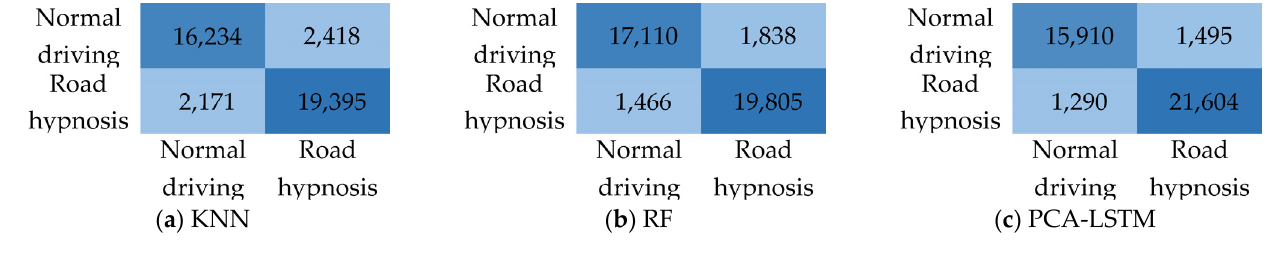
Figure 7. Confusion matrix of vehicle driving experiments.